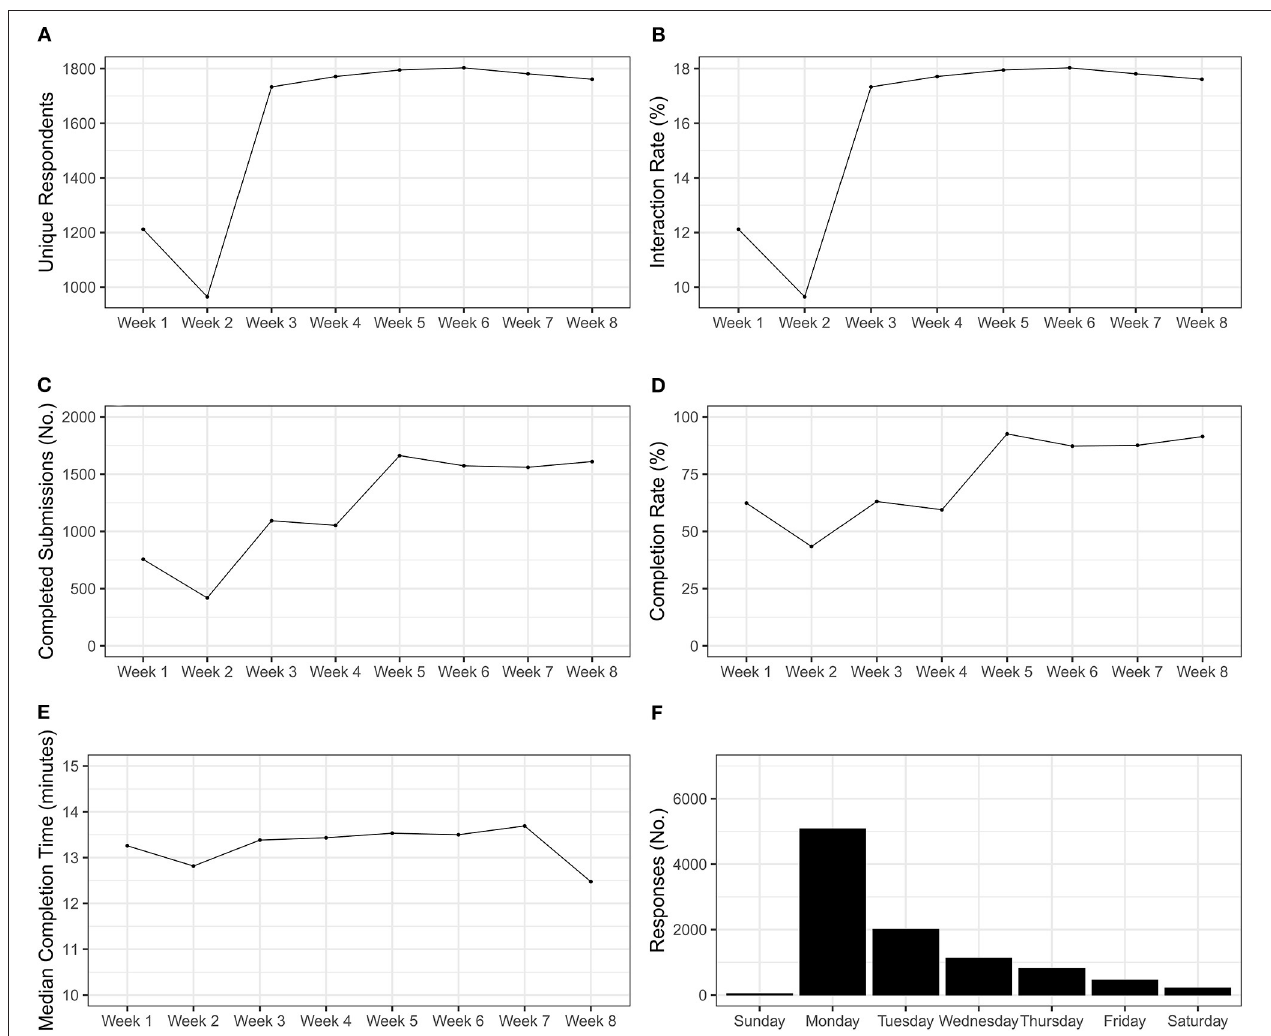
FIGURE 3 | Digital survey insights. (A) Total number of respondents per week of data collection. (B) Percentage of respondents who interacted with the survey following initial push messages. (C) Total number of completed submissions per week of data collection. (D) Percentage of respondents who completed the survey after starting an interaction. (E) Average time (in minutes) taken by respondents to complete the survey. (F) Number of unique responses per day across all data collection